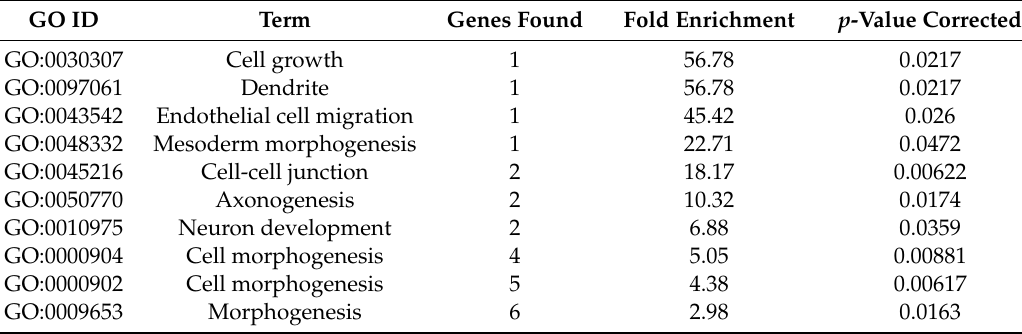
Table 3. The analysis of Gene Ontology (GO) biological process enrichment of the regions with common maternal transmission ratio distortion loci (TRDLs) detected in both Iberian